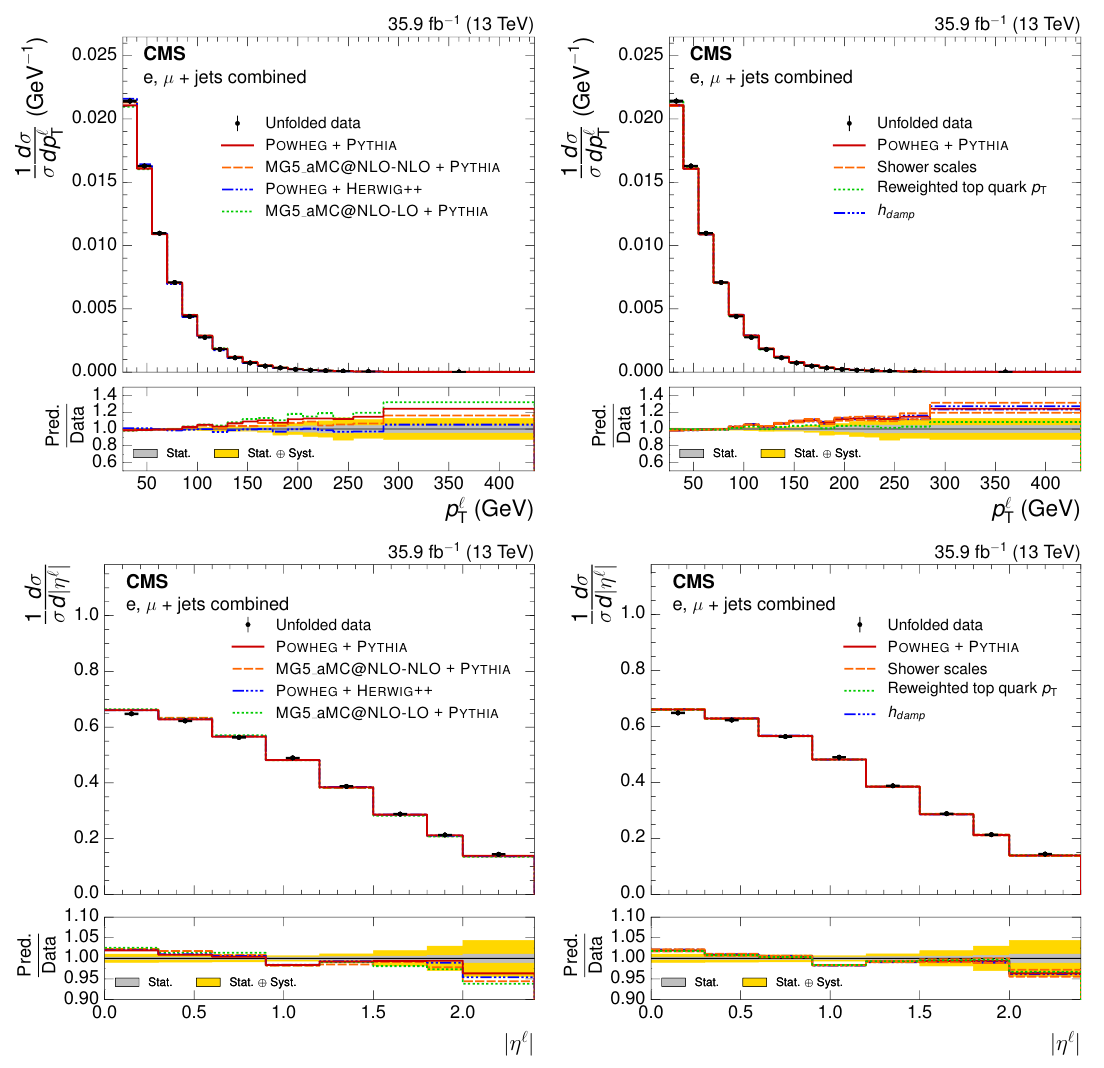
Figure 6 . Normalized p ‘ (upper) and (cid:17) ‘ (lower) di(cid:11)erential tt cross sections, compared to T j j di(cid:11)erent tt simulations in the left plots, and compared to the powheg + pythia simulation after varying the shower scales, and h damp parameter, within their uncertainties, in the right plots. The vertical bars on the data represent the statistical and systematic uncertainties added in quadrature. The bottom panels show the ratio of the predictions to the